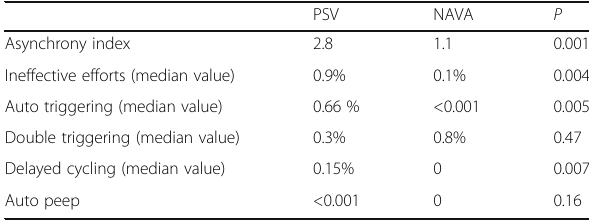
Table 1 (abstract 001630). prevalance of dyssynchrony in both groups